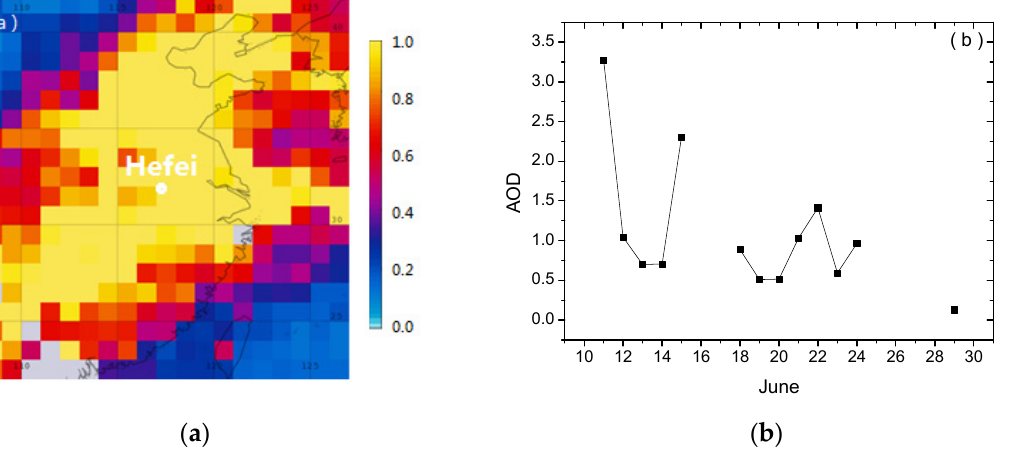
Figure 1. Time-averaged map of aerosol optical depth (AOD) at 550 nm over mid-eastern China derived from MODIS-Aqua data during June 2012 ( a ), and daily AOD during sampling period ( b ) over Hefei (region: 116–118E, 31–33N). White circle denotes the sampling site of Hefei. The data gaps in Figure 1b originate from the lack of MODIS-Aqua data (e.g., under cloudy weather conditions).